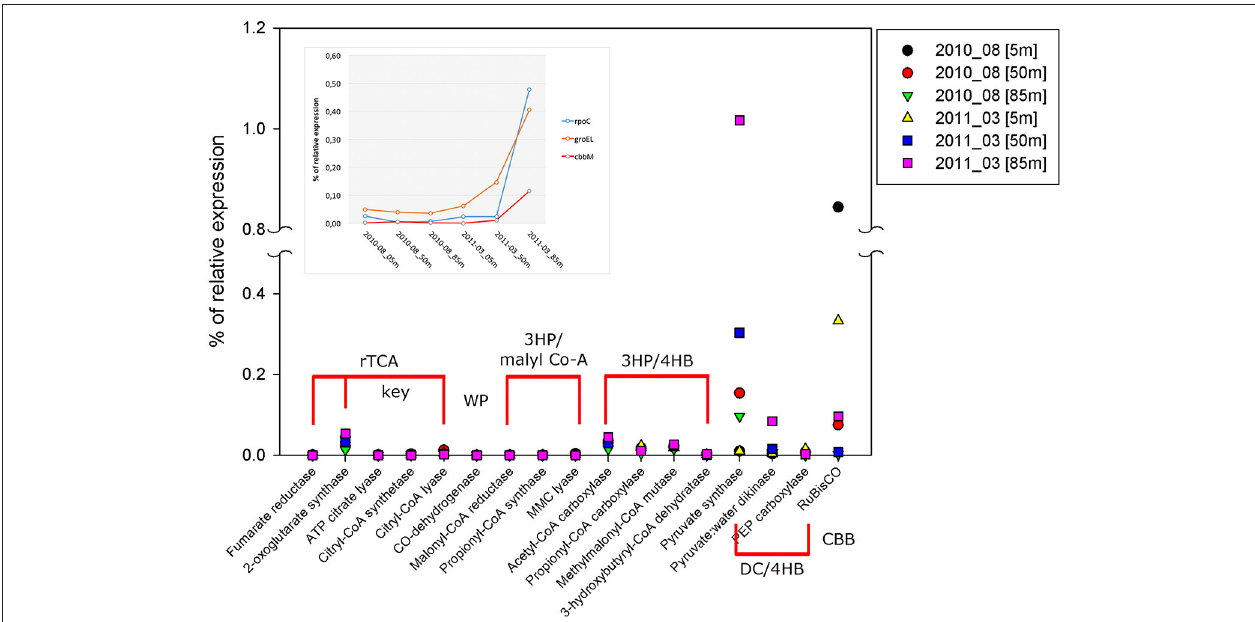
FIGURE 8 | Percentage of relative expression, from metatranscriptomic data, for the key and related genes of the six pathways of carbon fixation known to date: The reductive tricarboxylic acid (rTCA) cycle; the reductive acetyl-CoA or Wood-Ljungdahl (WL) pathway; the 3-hydroxypropionate (3-HP) bicycle; the 3-hydroxypropionate/4- hydroxybutyrate (3-HP/4-HB); the dicarboxylate/4-hydroxybutyrate (DC/4-HB) and Calvin-Benson-Bassham (CBB) cycle. The inset shows the percentage of relative expression of groEL , rpoC, and cbbM from each metatranscriptom analyzed, only the sequences associated to the GSO group were plotted. Both groEL and rpoC are used as internal controls of relative expression for each dataset.